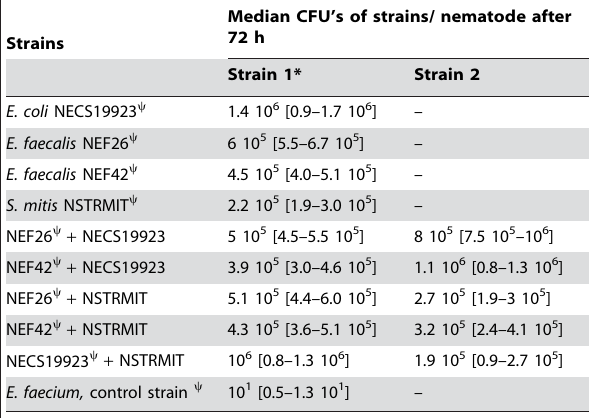
Table 2. Evaluation of the number of bacteria within the C. elegans digestive